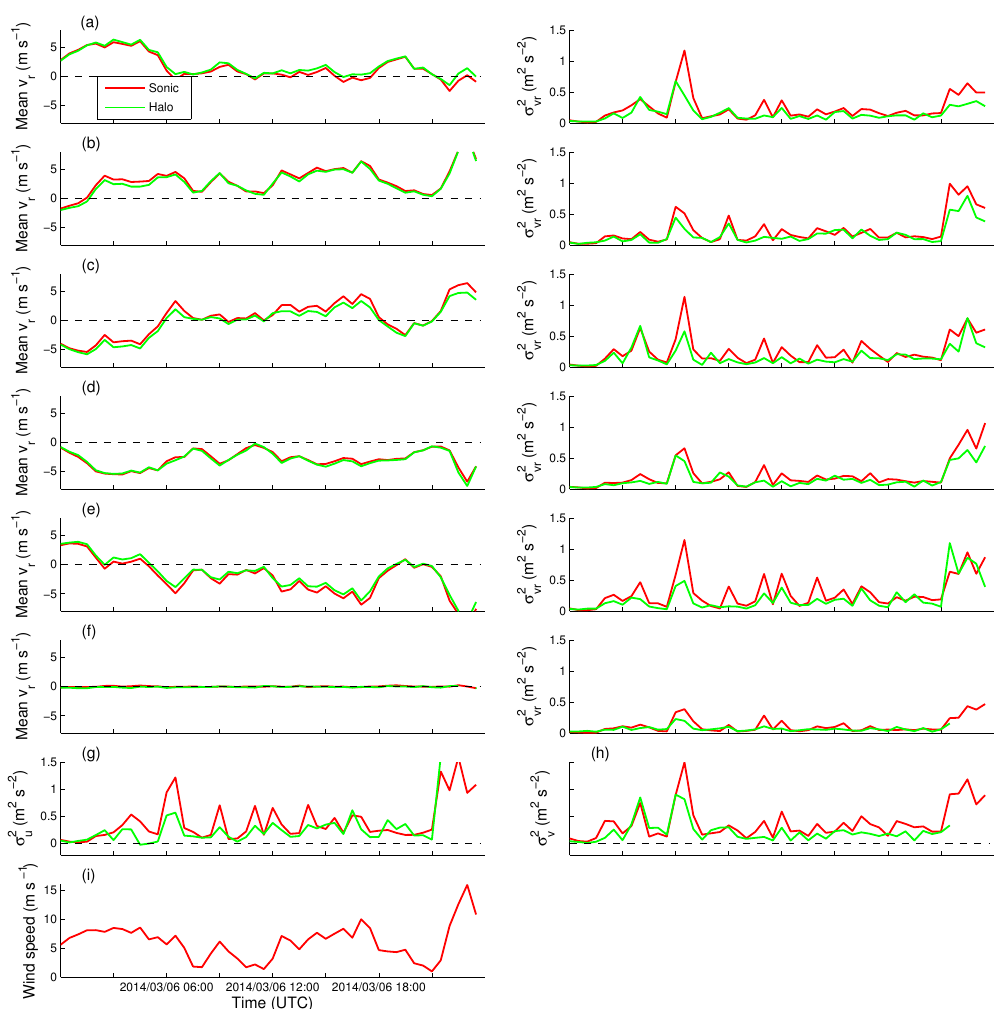
Figure 8. As in Fig. 7 but for 6 March 2014. Richardson number is not shown, because the 10m temperature sensor had data quality issues on this day (possibly related to tower